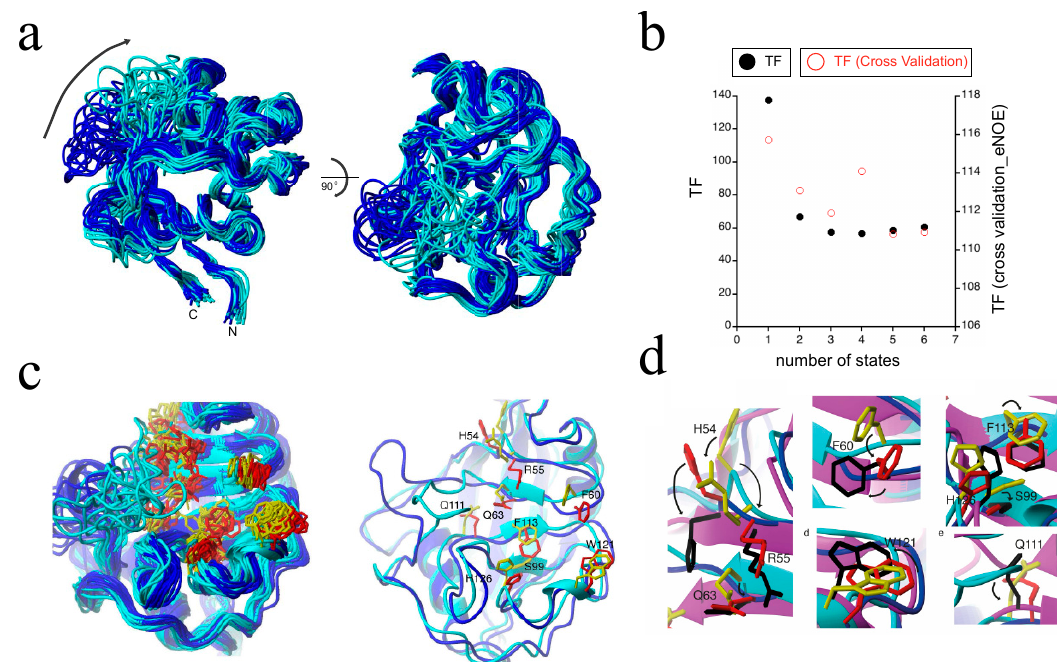
Figure 8. The eNOE detection of an allosteric network in cyclophilin A. ( a ) A structural ensemble of cyclophilin A in its apo form is shown, highlighting the presence of two distinct states. Each of the 20 conformers represents two states. States were color-coded as open (blue) and closed (cyan). Two distinct states are observed throughout most of the structure. The orientation of the structural ensemble shown on the right is a 90 ◦ rotation of that on the left; ( b ) The dependence of the CYANA TF (black) and the overall TF from the jackknife-type cross-validation (red) are shown as functions of the number of states; ( c ) The two-state ensemble of the active site residues of cyclophilin A. On the left, a ribbon representation of the 20 conformers is shown, color-coded individually for the two states: the closed state is shown in cyan for the backbone and in yellow for the side chains of the active site, while the open state is shown in blue for the backbone and in red for the side chains in the active site. The right shows a single representative from each state, with the side chains labeled. The lowest energy two-state conformers were selected; ( d ) Proposed mechanism of action of cyclophilin A at the atomic resolution. The X-ray structure of cyclophilin A in complex with the HIV-1 capsid protein (PDB ID: 1ak4 [59]) was superimposed with the presented two-state ensemble, which highlights the fact that the open-state matched the ligand-bound state well. The closed state is shown in cyan for the backbone ribbon and in yellow for the side chains, the open state in blue for the backbone ribbon and in red for the side chains, and the X-ray structure is shown in purple for the backbone ribbon and in black for the side chains. Individual close-ups of the superposition are shown. The potential modes of action for catalysis of the individual residues are indicated by arrows. Reprinted from [36], Copyright (2015), with permission from